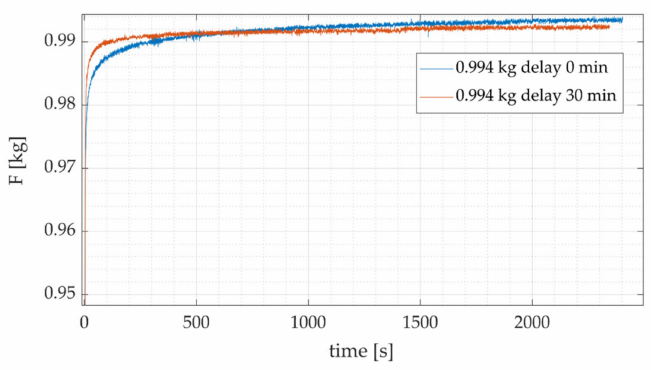
Figure 11. Force measurement for 0.994 kg with and without